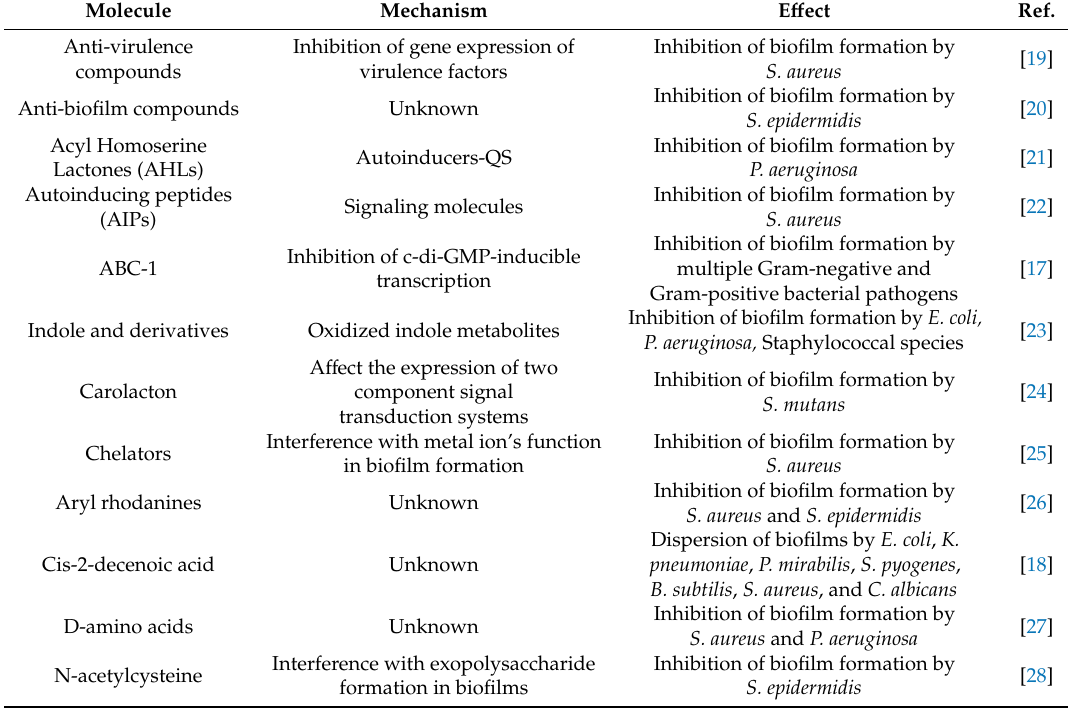
Table 1. Small molecules with antibiofilm